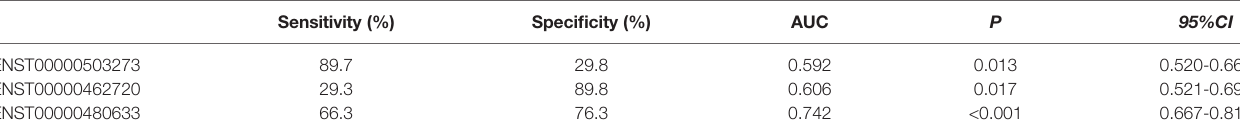
TABLE 4 | The Diagnostic Values of LncRNAs (ROC curve).